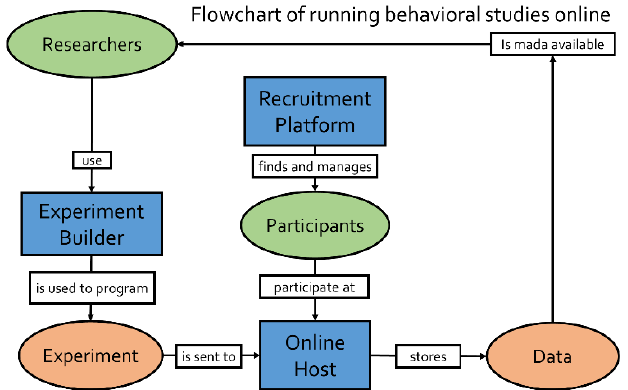
(Table 1: B, C, D) in solving only individual steps of the process, whereas other providers o ff er a more holistic integrated-service ecosystem (Table 1: A). In Section 2.4. we will discuss the considerations one should make when picking an ecosystem, but we will abstain for making strong recommendations and claims at this point. Notably, we limited this overview to software that appears to be under active development to ensure steady security updates (with updates in 2019).